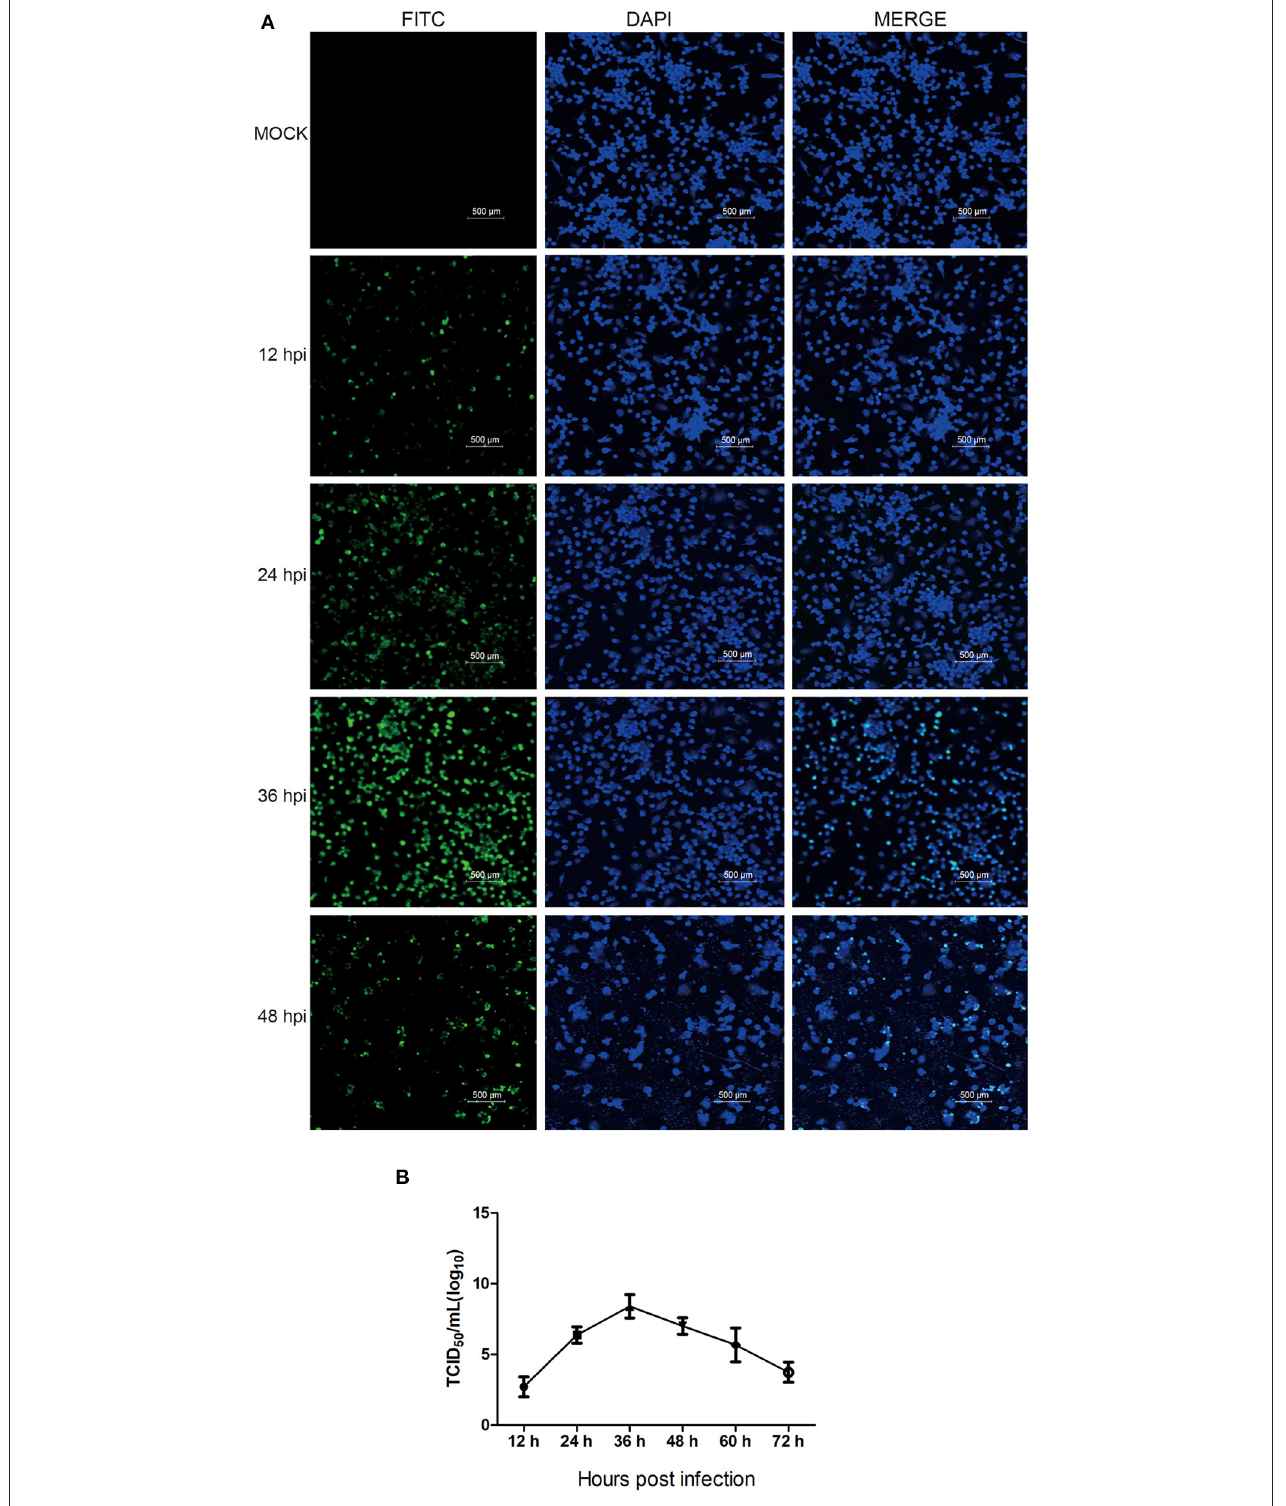
FIGURE 1 | The propagation kinetics of HP-PRRSV HN07-1 in PAMs. (A) PAMs were infected with HP-PRRSV HN07-1 at MOI = 0.1 for 12, 24, 36, and 48h or were mock-infected for 36h as a control. Fluorescent images were recorded using an OLYMPUS IX 81 confocal microscope based on detection of virus using anti-PRRSV N protein antibody. (B) The one-step growth curve of HP-PRRSV HN07-1 in PAMs based on viral titers at 12, 24, 36, 48, 60, and 72 hpi.